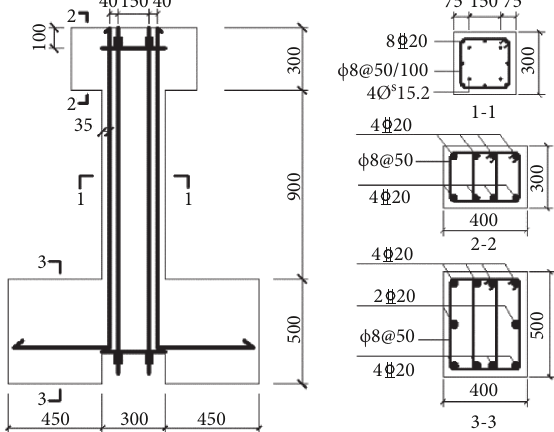
Figure 1: Size and section reinforcement of test columns